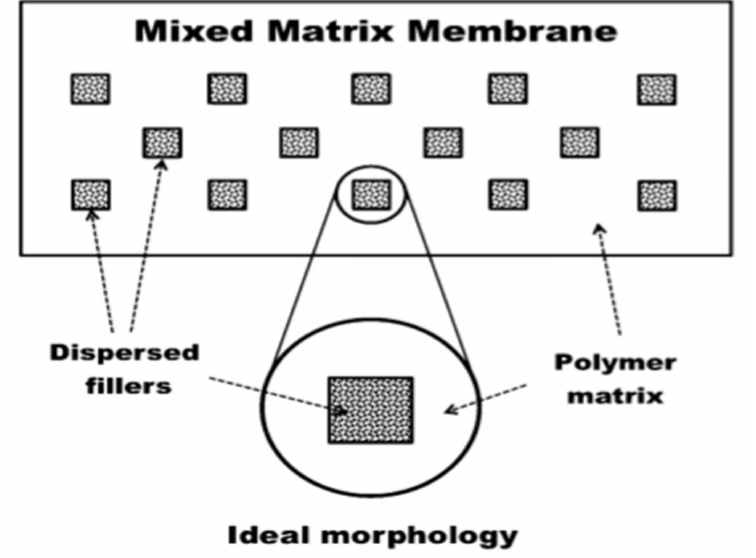
Figure 12. Schematic diagram of ideal MMM morphology [100]. Reprinted/adapted with permission from Ref. [100]. Copyright 2022,